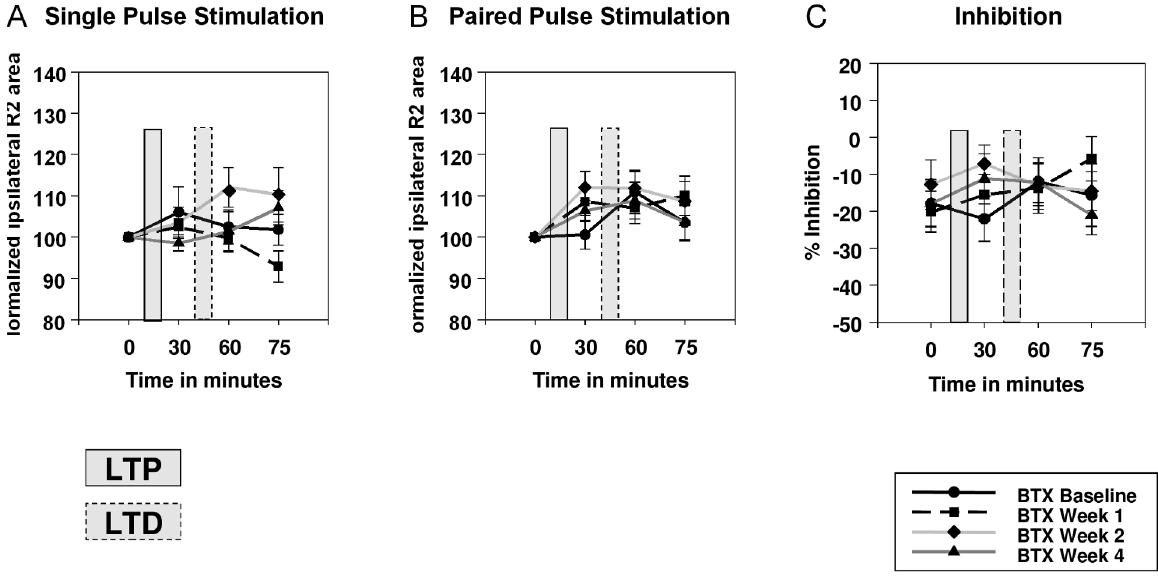
Figure 8. HFS LTP-LTD before and after Botulinum Toxin Treatment. Results of normalized data for HFS before and after Botulinum toxin (BTX) treatment in BEB patients are shown for HFS LTP-LTD . Panel A : Single pulse; Panel B : Paired-pulse. BTX had no effect on the HFS LTP-LTD protocol. Black line with circle = baseline; black, dashed line with square = one week after BTX injection; light grey line with diamond = two weeks after BTX; dark grey line with triangle = four weeks after BTX. R2 area under the curve is given in m V/sec. % inhibition is relative to single pulse measurements.